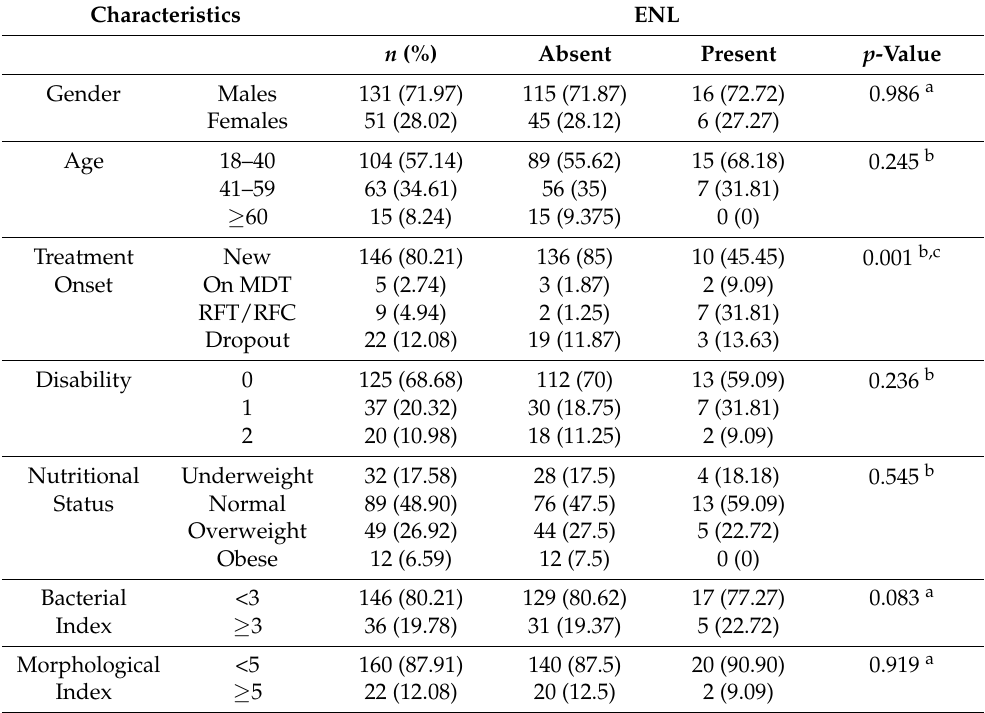
Table 1. Clinical characteristics of ENL in new MB leprosy patients.